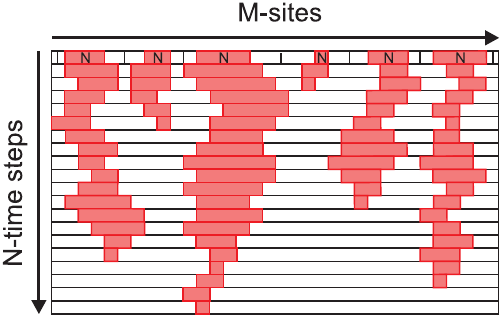
Figure 30. Illustration of a random-walk annihilation process of neutral-ionic domain walls (NIDW) along a one-dimensional chain with the length M . Neutral domains (red) are embedded in the ionic phase (white) separated from each other by NIDWs. After several time steps, the neutral domain collapses which is the same for the annihilation of two NIDWs.